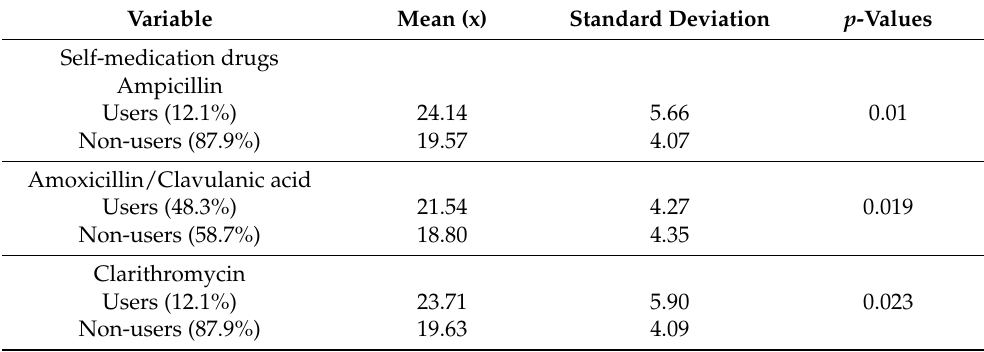
Table 2. Self-medication